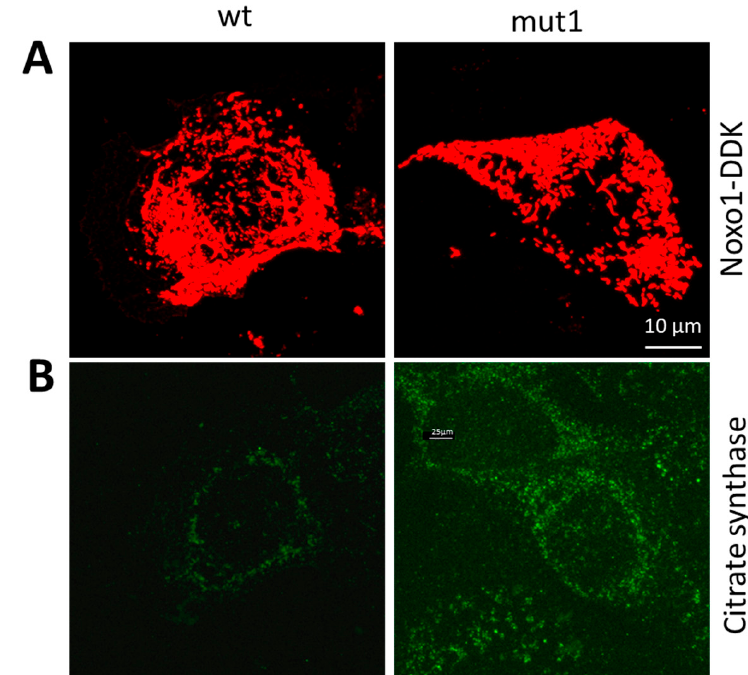
Figure A2. Immunofluorescence Noxo1 with vimentin in Caco-2 transfected with wt Noxo1- or mut1 Noxo1-DDK. Immunofluorescence wt Noxo1-DDK (left upper panel, green) and vimentin (middle upper panel, red). The overlay upper right panel corresponds to wt Noxo1-DDK/vimentin Immunofluorescence mut1 Noxo1-DDK (left lower panel, green) and vimentin (middle lower panel, red). The overlay (right upper panel) corresponds to mut1 Noxo1-DDK/vimentin. Mut1 Noxo1-DDK alters the pattern of vimentin. There is a clear colocalization of Noxo1 with vimentin at many spots or filamentous sites for either the wt or mut1 form of Noxo1 (yellow).